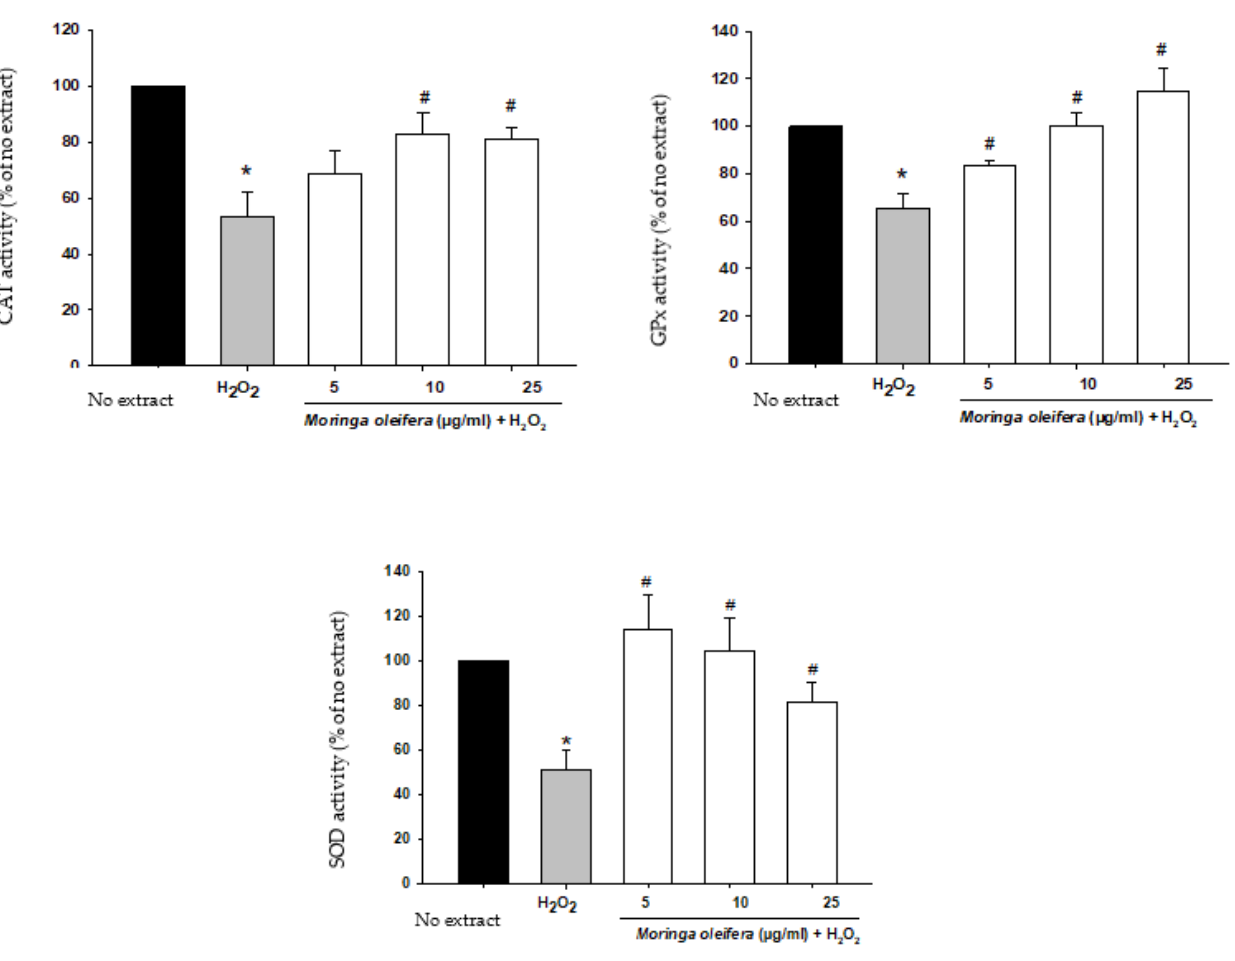
Figure 4. Effect of methanol extracts of Moringa oleifera leaf powder on antioxidant enzyme activity. Cells were pretreated with moringa (5, 10 and 25 µg/ml) for 24 h before 100 µM H 2 O 2 for 1 h. * p < 0.05 versus extract, # p < 0.05 versus H 2 O 2.